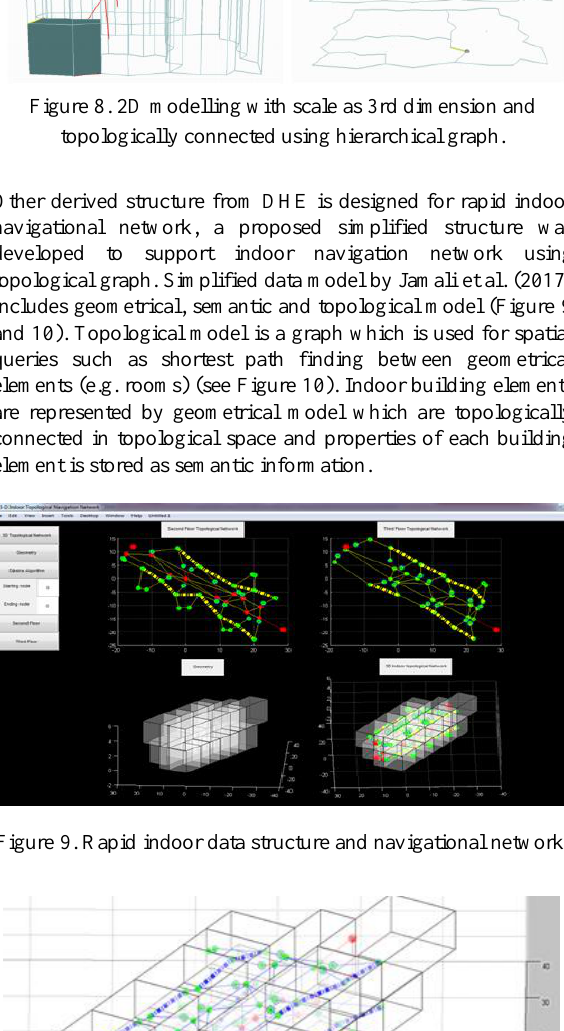
Figure 7. The DHE data structure models 3D subdivisions by representing the boundary of each polyhedron separately with a graph (solid lines), and two adjacent polyhedra are linked together by the dual graph (dashed lines). Both graphs are inter- connected (Boguslawski et al., 2011).